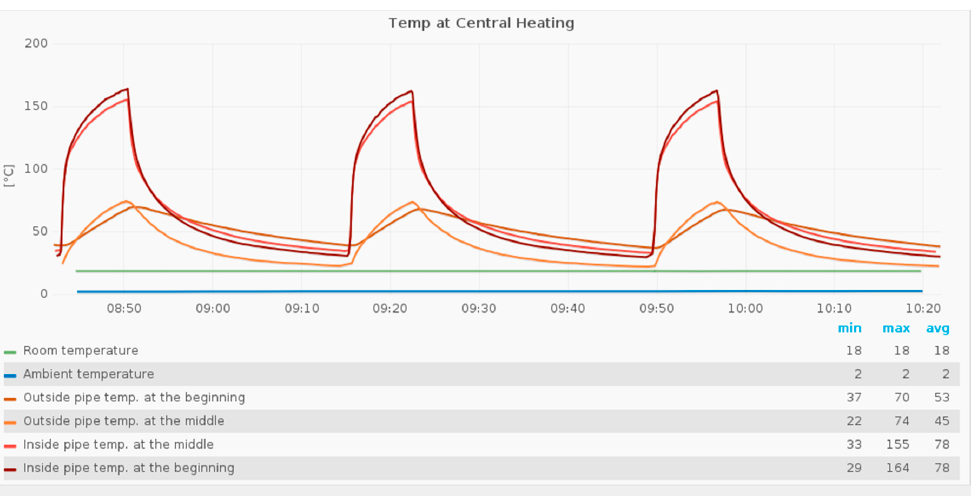
Figure 1. Measured temperatures at an oil-fired heating on the campus, visualized by the web interface. Visible are the aforementioned temperatures and an approx. 20/80 on/off behavior of the heating.